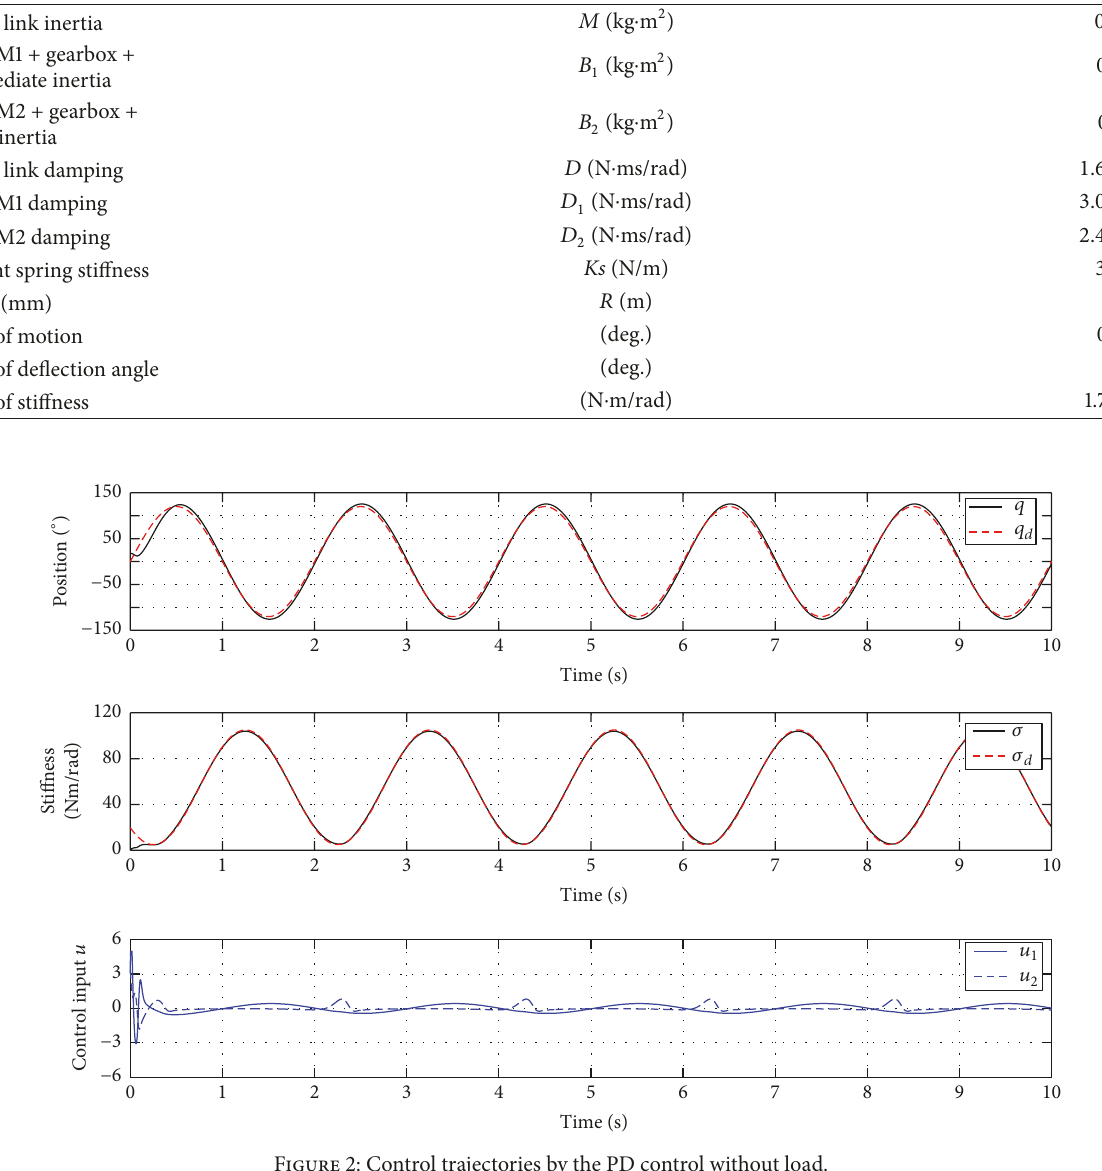
Figure 2: Control trajectories by the PD control without